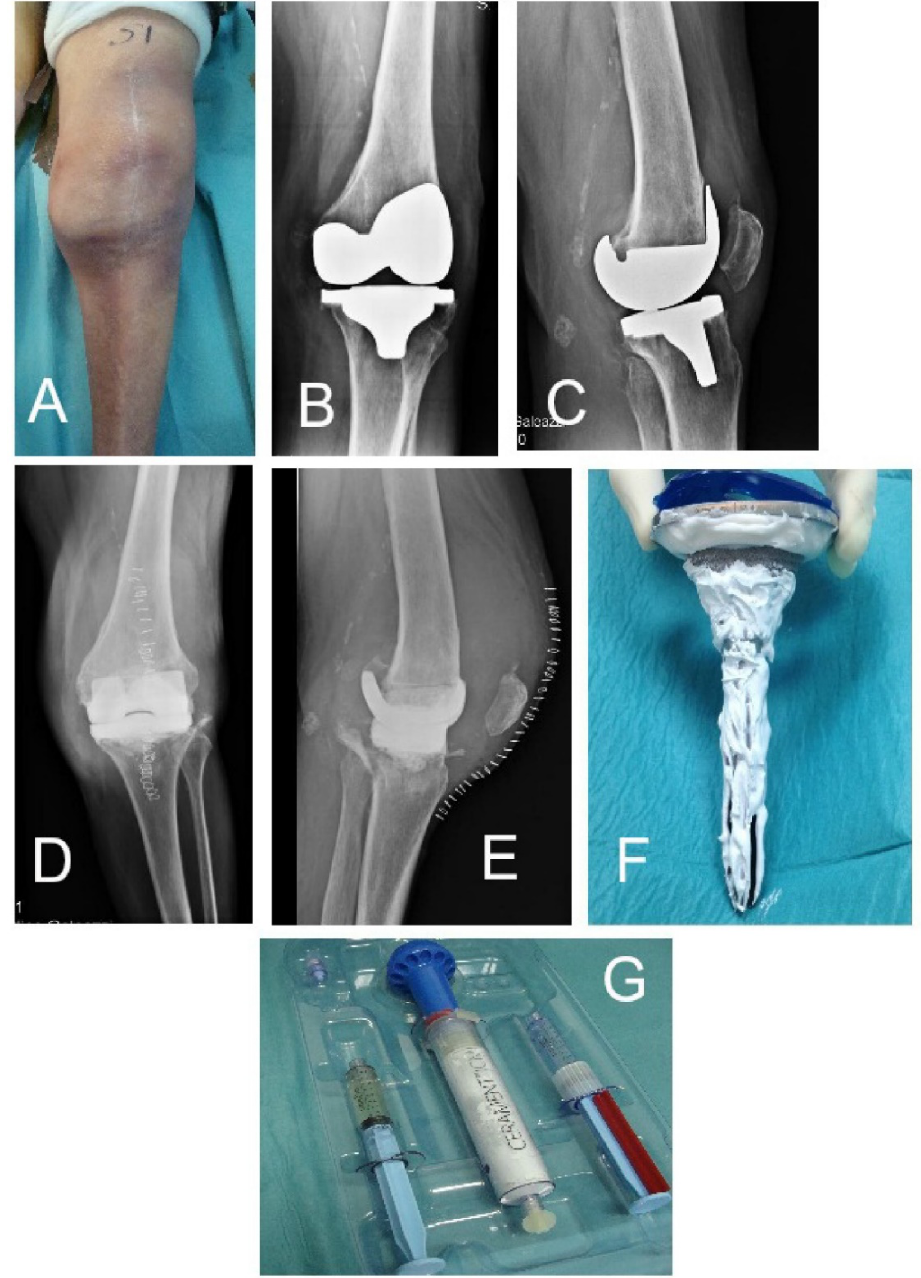
Figure 1. Patient n. 3 (see Table 1). (A) pre-operative clinical aspect, (B,C) pre-operative radiographic findings with implant loosening and osteolysis and (D,E) after antibiotic-loaded spacer implanted. (F,G) Cerament G preparation kit and the coated implant at the time of